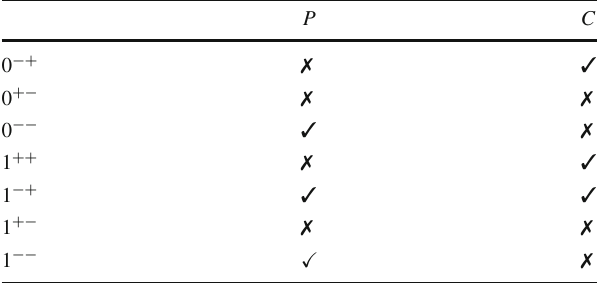
Table 1 Symmetries for XG 2 terms involving a heavy nonscalar glue- ball X and two scalar glueballs